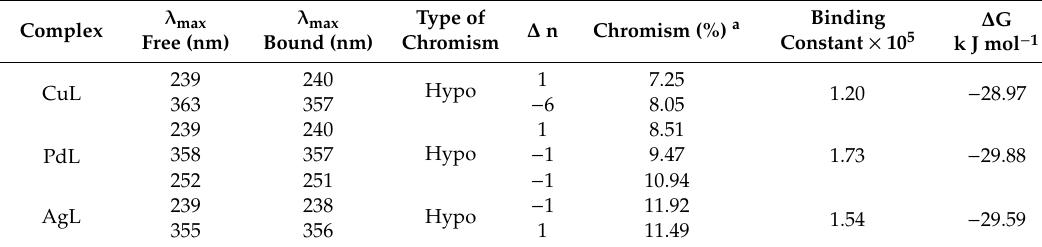
Figure 6. ( a ) Electronic spectroscopy for the interaction of CuL complex (10 − 3 M) with (0–100 μ M) CT-DNA in 0.01 M tris buffer at 298 K and ( b ) plot of [DNA]/( ε a – ε b ) versus [DNA] for the interaction CT-DNA. Table 9. Spectroscopic parameters and binding constant results of the CT-DNA reaction with the new